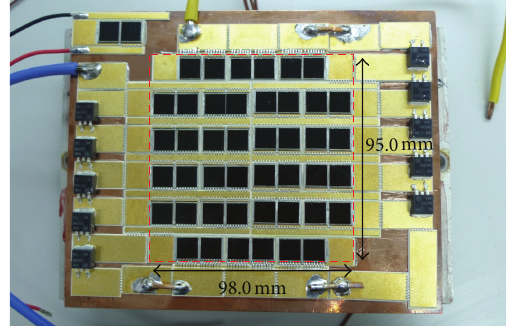
Figure 16: P-V curve of the optimized array’s measured data (red line with dots) is superimposed on FPM simulation curve (black line) and Matlab simulation curve (blue dashed line).